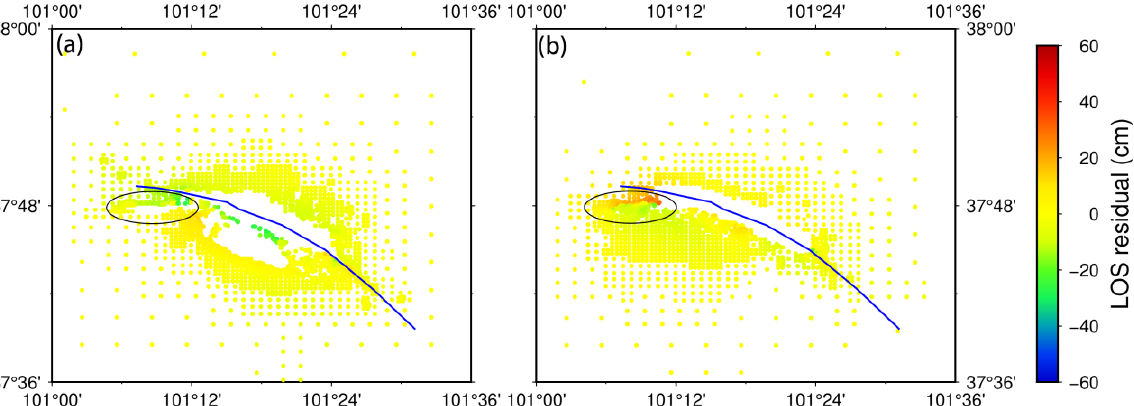
Figure 6. InSAR line-of-sight (LOS) displacement residual from ascending ( a ) and descending ( b ) tracks using only single fault (main fault only) inversion. The blue line is the fault geometry used in the modelling. Black ellipse in ( a ) and ( b ) marks significant residuals at the western end of the main fault, implying a secondary fault strand.